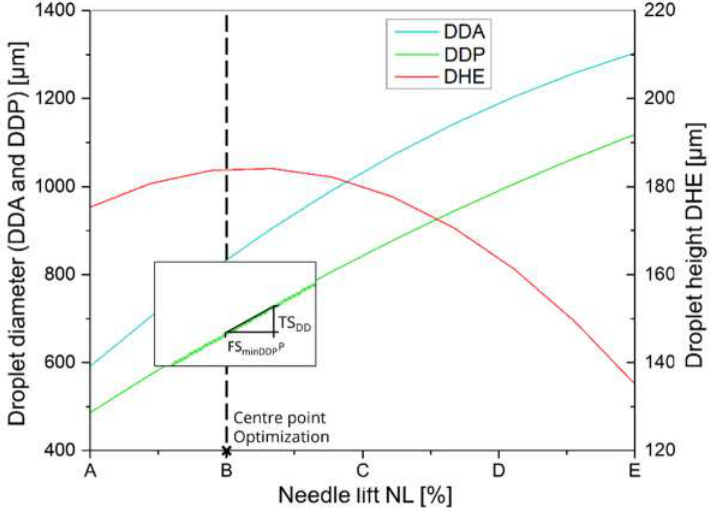
Figure 7. Relationship between the selectivity and minimum factor step in hypothesis testing.